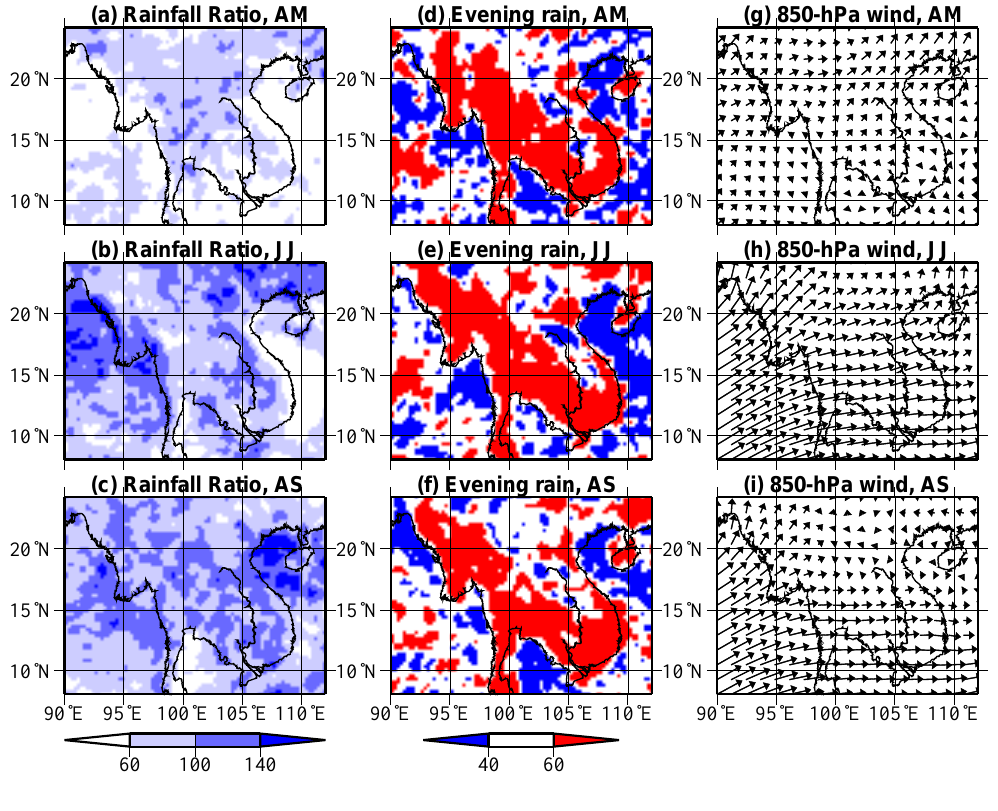
Fig. 2. The rainfall ratio (a–c) , the contribution rate of evening rainfall (d–f) , and the low-level winds (g–i) during AM (April and May), JJ (June and July), and AS (August and September). The definitions of the rainfall ratio, and contribution rate of evening rainfall are given in Sect. 2. In (d), (e), and (f), blue (red) color indicates a region that evening rainfall is larger (smaller) than morning